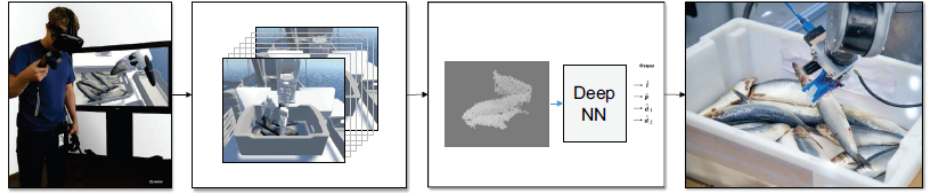
Figure 11. Imitation learning in VR